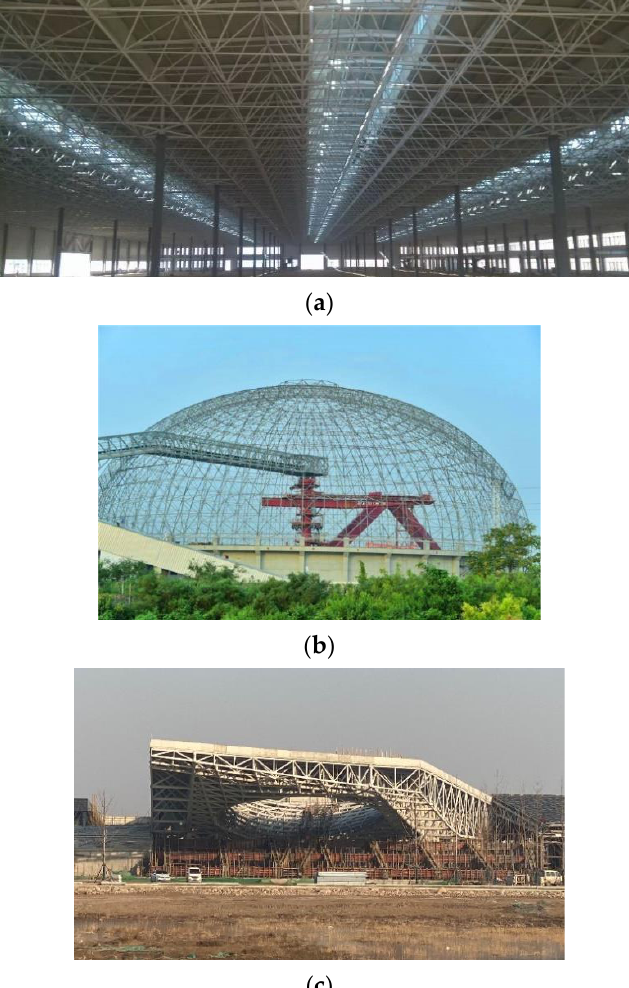
Figure 1. Space frame structures. ( a ) Space truss; ( b ) Latticed shell; ( c ) Spatial truss.